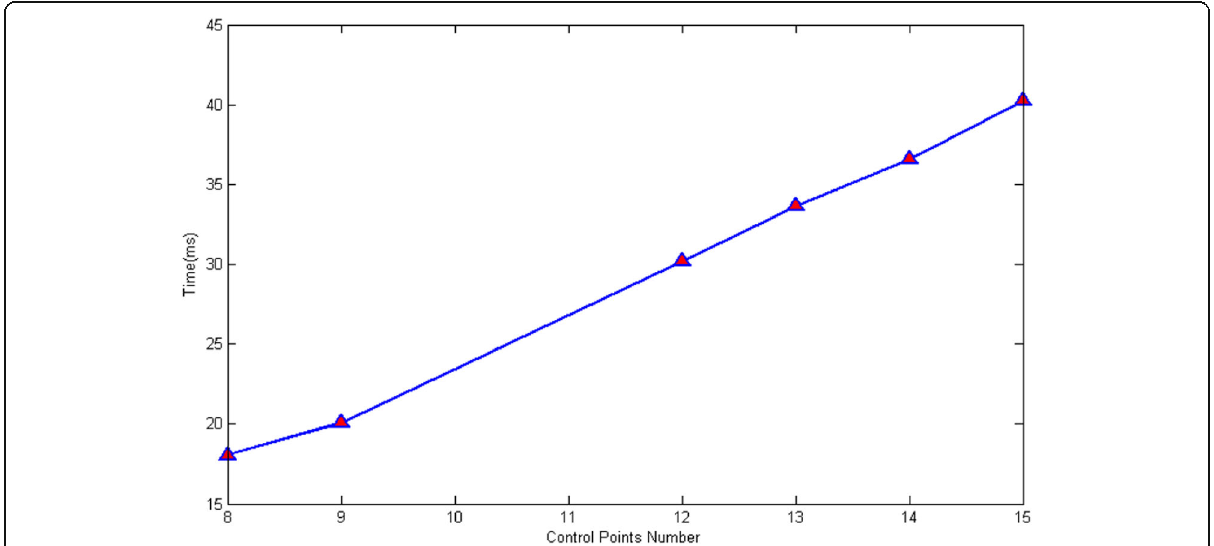
Fig. 13 The relationship between time consuming and the number of control points of test video “ Hand3